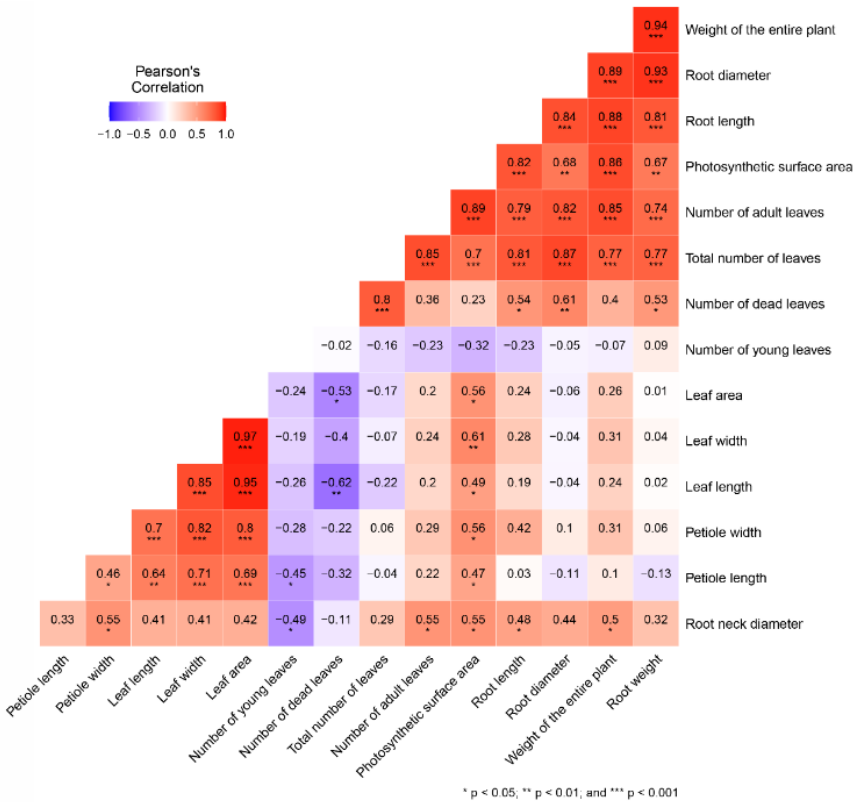
Figure 6. Correlogram showing the correlations between different morphological characters in the white-colored beetroot group 4 ( n = 100 replications). The numbers inside each square show the Pearson R correlation values.